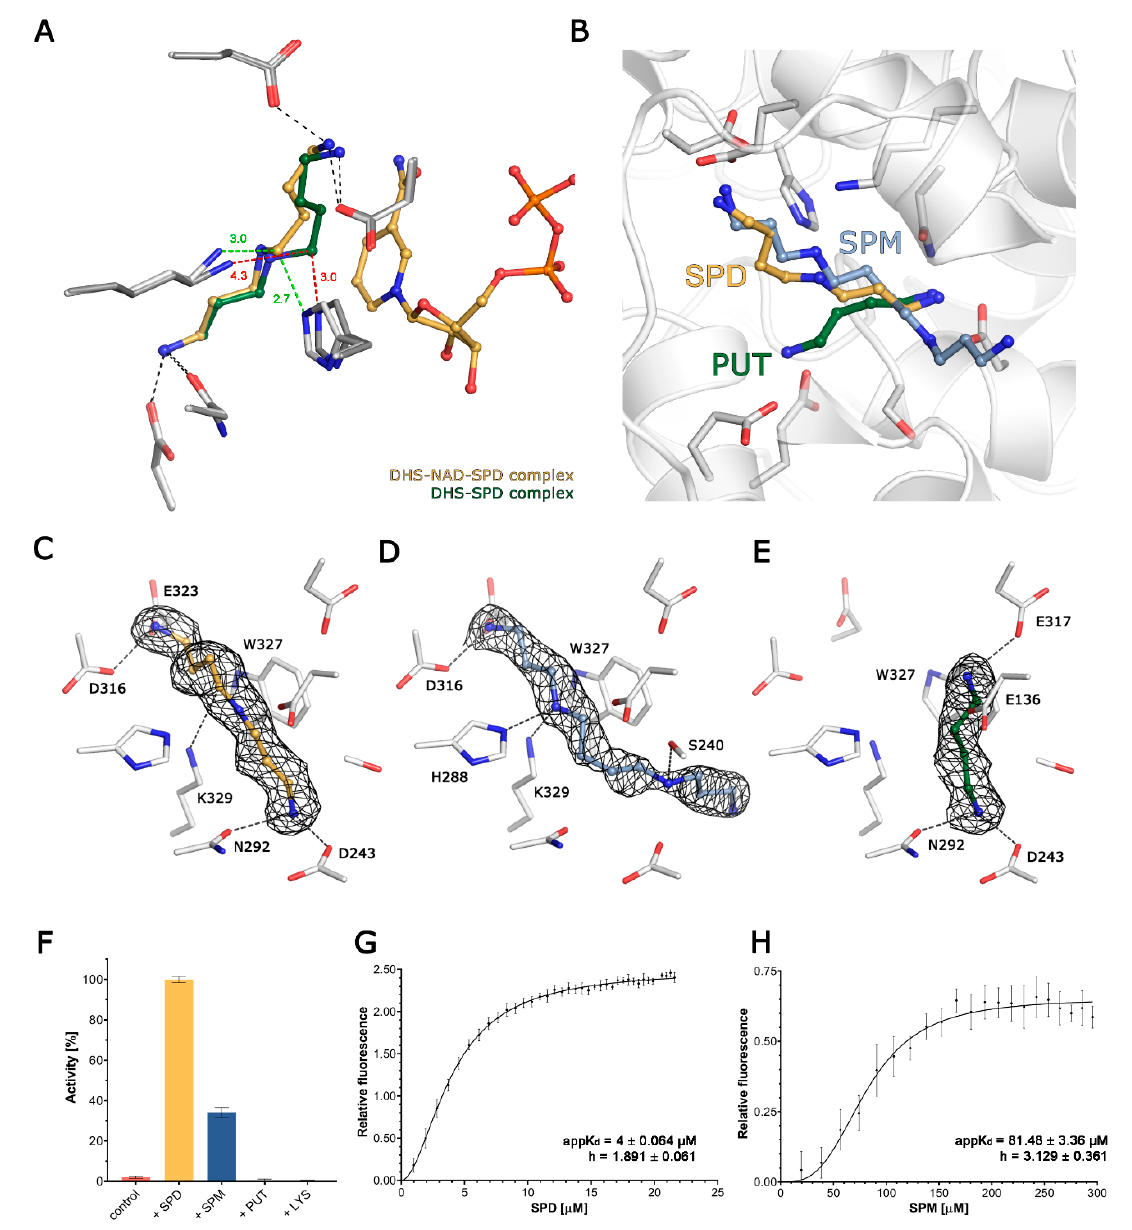
Figure 2. The binding of polyamines to DHS. ( A ) The superposition of binary DHS-SPD and ternary DHS-NAD-SPD complexes. The ligands are shown as balls and sticks, with carbons coloured green in binary complexes and yellow in ternary complexes respectively. The side chains for the residues coordinating SPD are shown as sticks, in light grey for DHS-NAD-SPD and in dark grey for DHS-SPD. The change in conformation of SPD induced by the presence of NAD is highlighted by a change of distances between C5 and His288 and the catalytical lysine 329, coloured red and green for binary and ternary complexes respectively. ( B ) Superposition of the DHS-SPD, DHS-SPM and DHS-PUT complex structures shows the relative positions of the investigated polyamines in the active site. Ligands are represented as balls and sticks, and the residues forming binding sites are shown as sticks. ( C – E ) The binding of SPD, SPM and PUT is shown with ligand as balls and sticks. 2Fo-Fc composite omit maps countered at 1 σ are shown as a black mesh for each ligand. Residues taking part in the binding of each ligand are labelled. ( F ) The relative activity of DHS, expressed as an increase in the NAD fluorescence in the presence of various ligands. ( G , H ) A FRET binding assay for SPD and